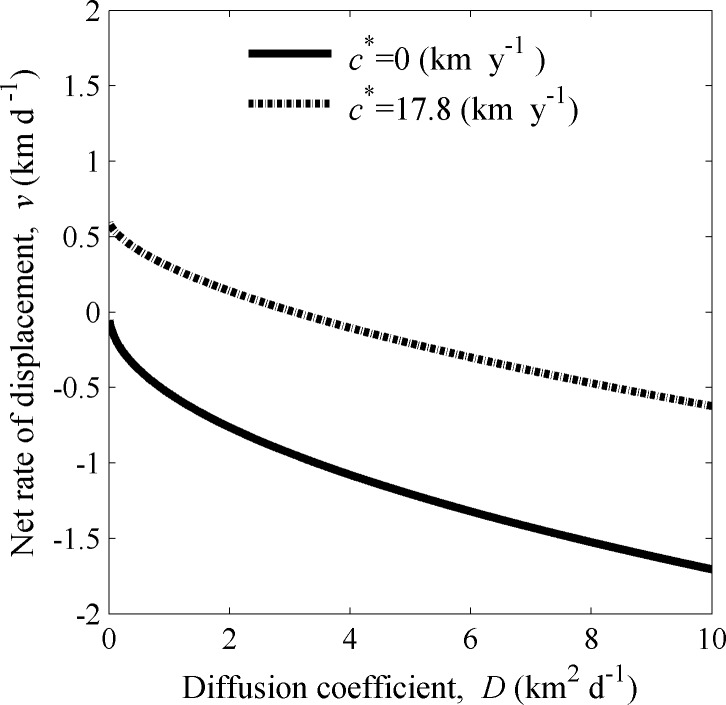
Contours for spread rate c* against a dominant current.The solid line shows the threshold for northward spread, i.e., the relationship between net rate of displacement v and diffusion coefficient D suggested by our model (Eqs 1–5) beyond which northward spread can occur (c* ≥ 0 km y-1). A pair of values of v and D is referred as a “good-year” pair if it lies above this threshold, otherwise the pair is referred as a “bad-year” pair. The dash-dot line is the contour for c* = 17.8 km y-1, which is the estimated northward spread rate of the northern lineage of the green crab in the Northumberland Strait, Canada [9]. The other model parameters were fixed as adult survival probability bA = 0.8, recruitment rate r = 23 adult female offspring per female adult per year, and the start and end of the larval settlement period T1 = 50 and T2 = 90 days.